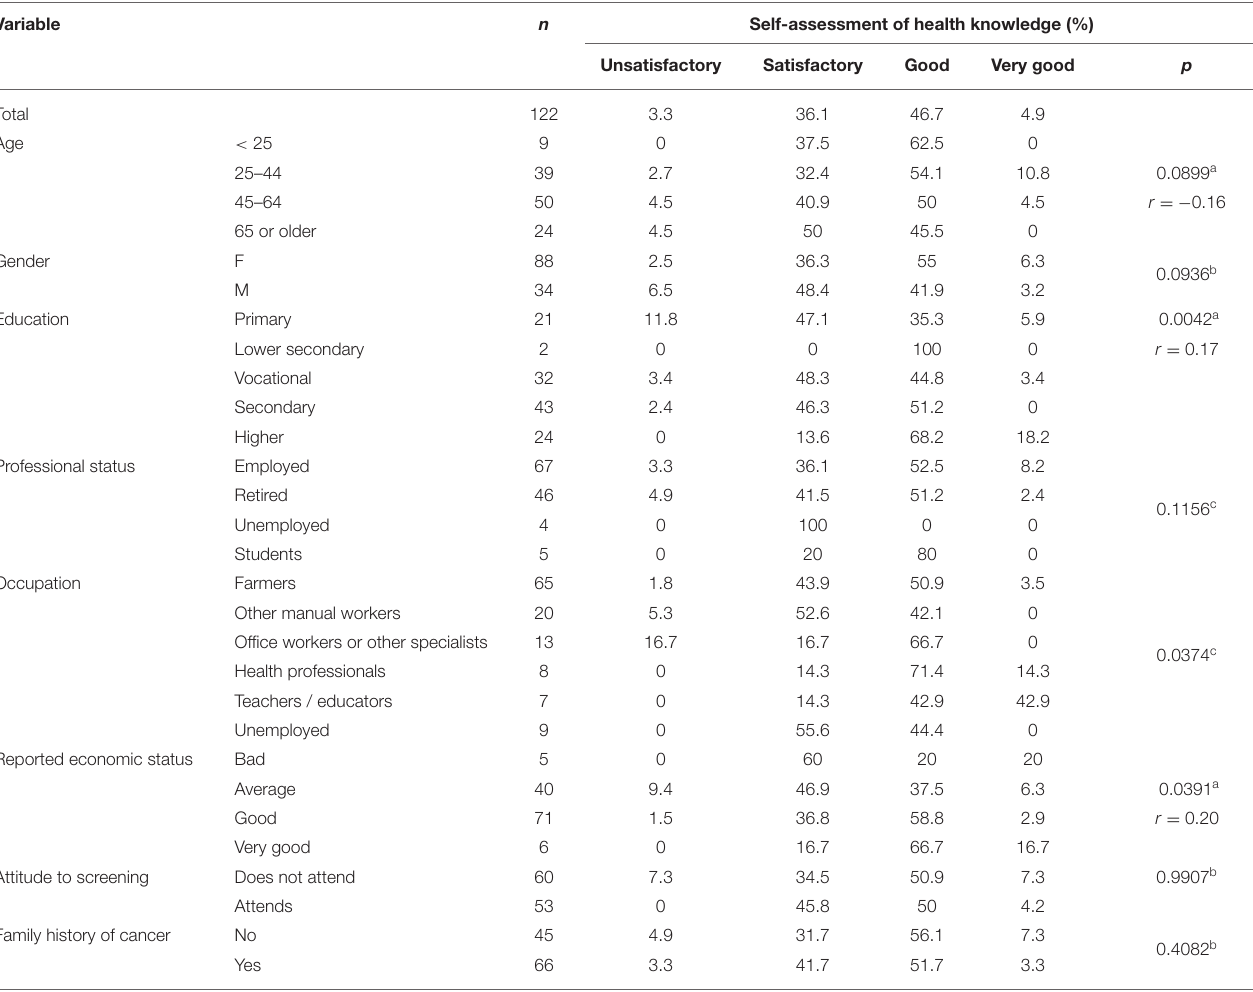
TABLE 1 | Self-assessment of health knowledge ( n = 122).